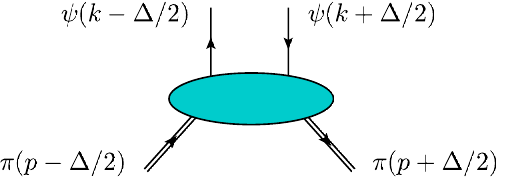
Fig. 1 Momentum-space conventions used in defining the in-pion quark–quark correlator in Eq. (1)